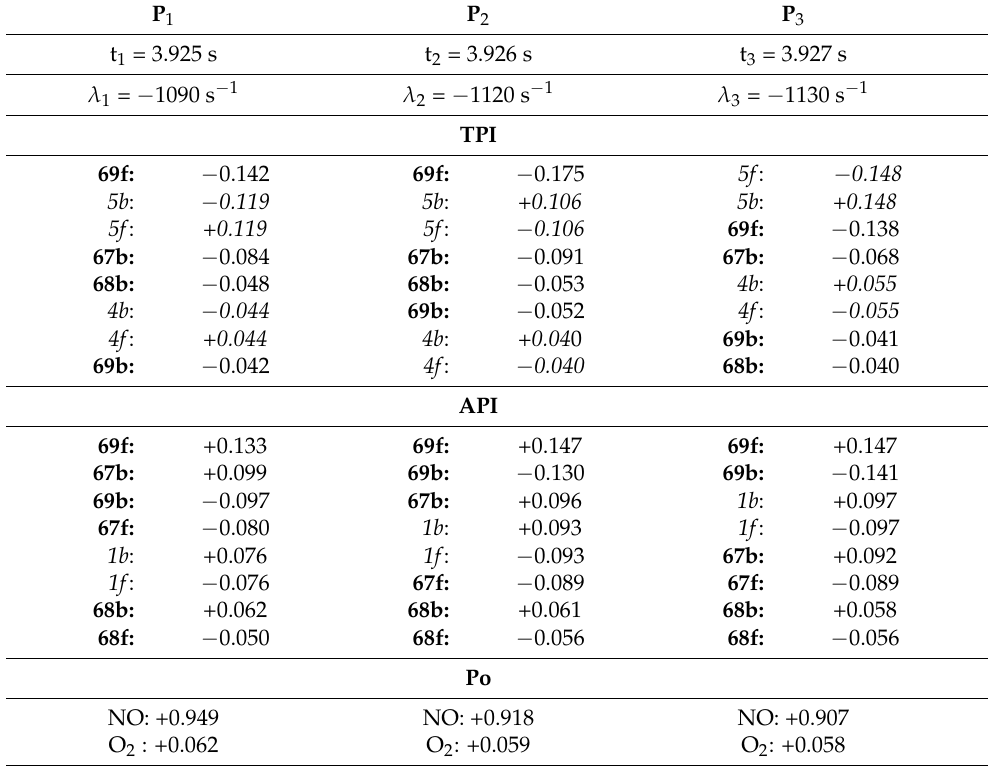
Table 3. The largest TPI, API and Po values for the slow mode that relates to NO at the points P 1 to P 3 shown in Figure 3; Only contributions larger than 5% are shown. In italics are contributions to TPI and API by pairs of forward and backward directions of the same reaction canceling each